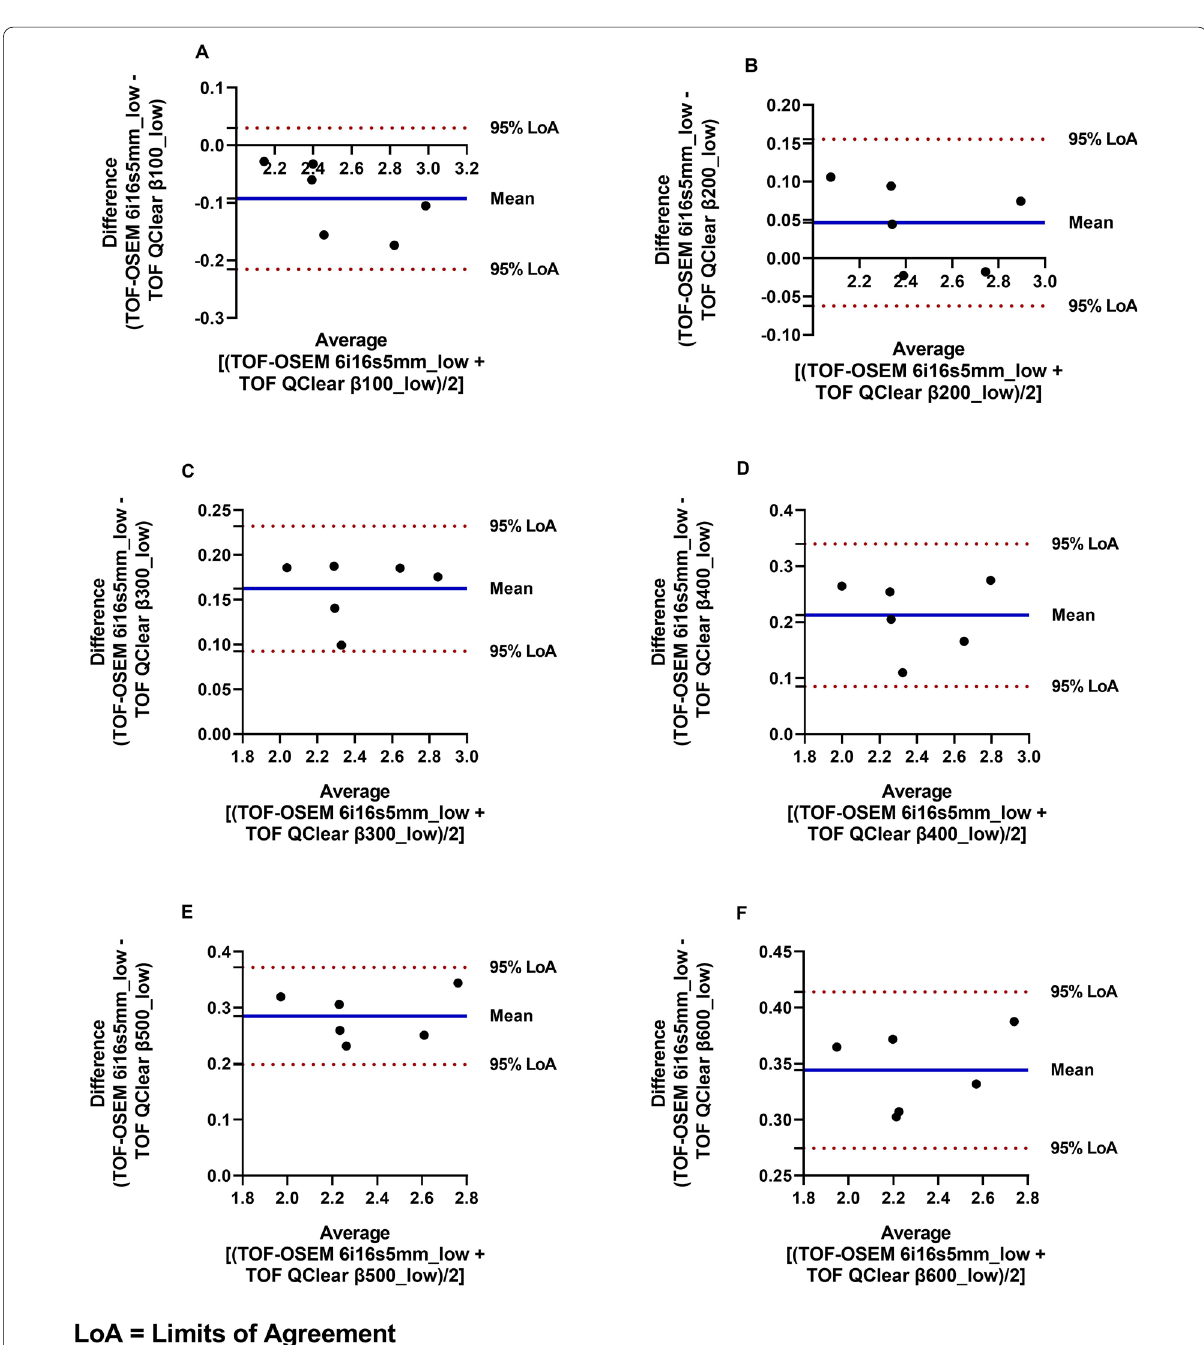
Fig. 3 Bland–Altman plots of the BP ND obtained for the Striatum: A TOF OSEM 6i16s5mm_low versus TOF Q.Clear β100_low; B TOF OSEM 6i16s5mm_low versus TOF Q.Clear β200_low; C TOF OSEM 6i16s5mm_low versus TOF Q.Clear β300_low; D TOF OSEM 6i16s5mm _low versus TOF Q.Clear β400_low; E TOF OSEM 6i16s5mm_low versus TOF Q.Clear β500_low; F TOF OSEM 6i16s5mm_low versus TOF Q.Clear